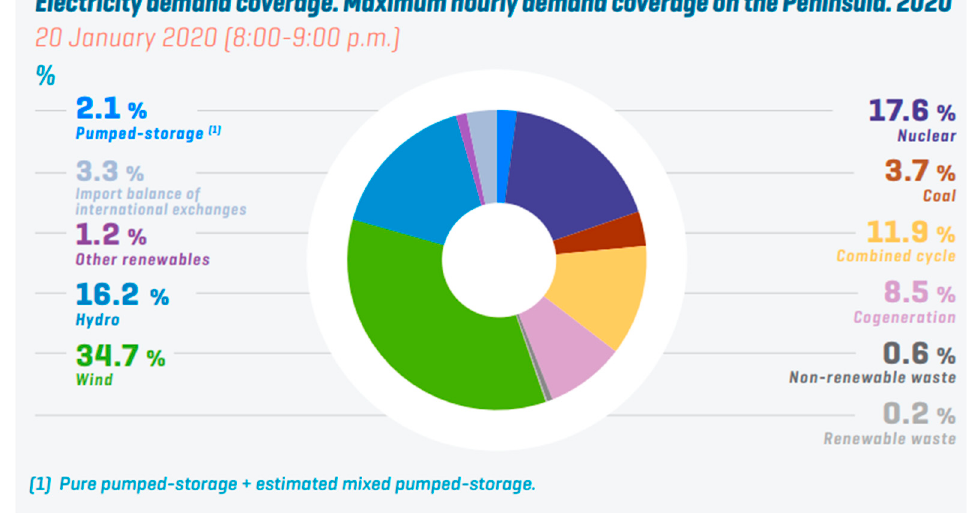
Figure 1. Electricity demand coverage for the maximum hourly demand coverage on the Spanish Peninsula, in 2020 [13].